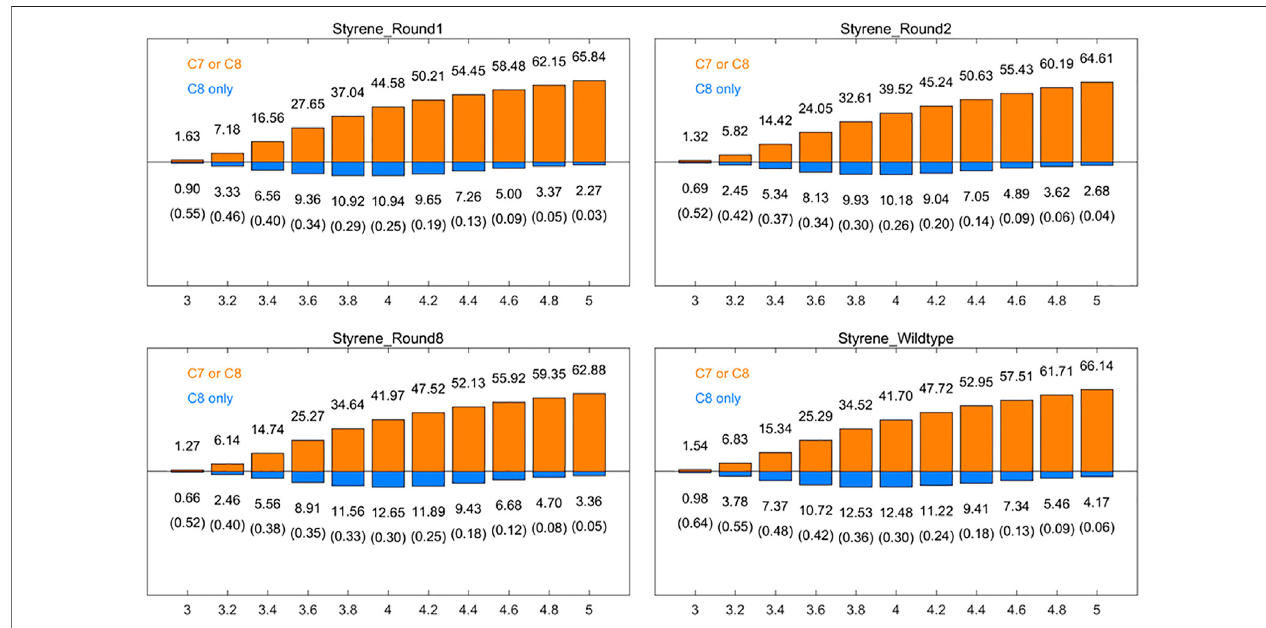
FIGURE1| Percentages[p(C7orC8),orange]oftheframesthathaveatleastonecarbon(ofstyrene ’ sposition1andposition2carbons)withinthegivendistance (x-axis,inÅ)totheCpdIoxygenamongalltheaMDframes,andthepercentages[p(C8only),blue]oftheframeswhereonlyposition1carbonofstyrenevinyliswithinthe given distance. The ratios of p (C8 only)/p (C7 or C8) are also listed in the brackets. All results are the averages of the corresponding ten 30 ns aMD trajectories.